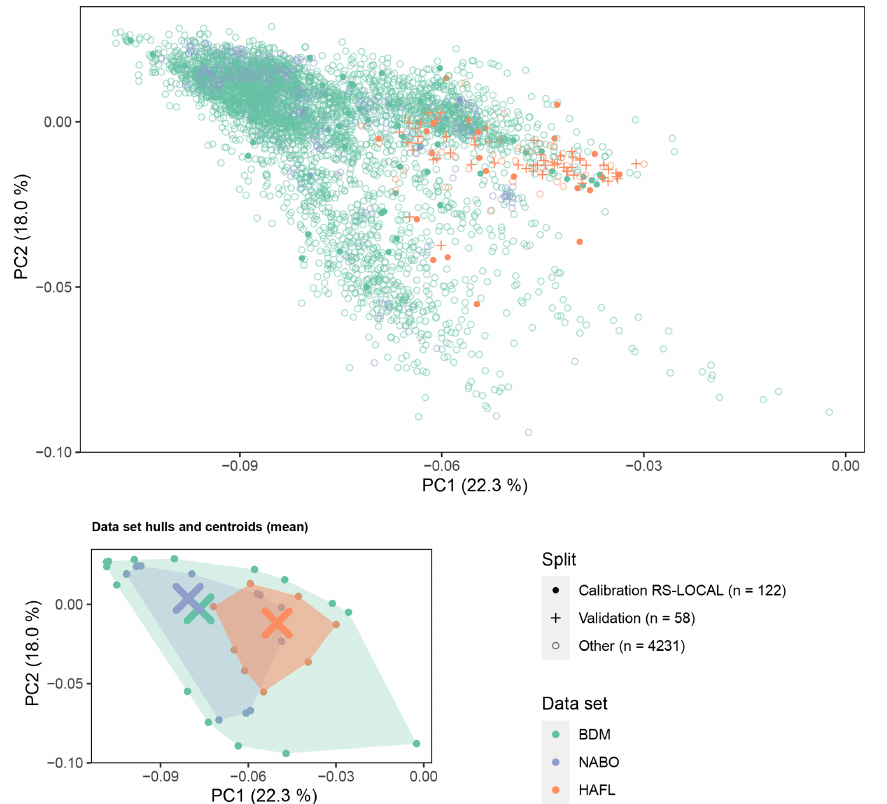
Figure 5. PC1 vs. PC2 and the convex hulls and centroids (mean) in the PCA space of the preprocessed soil spectra of the local HAFL data set ( n = 116) and the BDM and NABO data sets, which make up the current Swiss SSL ( n = 4295). Here, the PCs were computed via unscaled and uncentered PCA, since it showed the data distribution better than a scaled and centered PCA. The axes labels show the relative amount of variance explained (percent) in parentheses. In this example, the same representative local HAFL samples ( n = 20) selected in Fig. 4 were used by RS-LOCAL to subset representative samples from the SSL ( n = 102), which were used together for model calibration ( n =